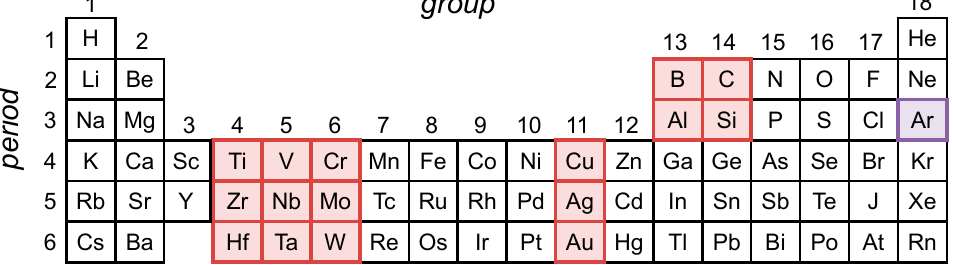
atoms, depending on the target material and the ion energy (i.e., the sputtering yield). Such numbers provided adequate statistics for the evaluation of the differential sputtering yields. The “detailed calculation with full damage cascades” type was chosen for the calculation. The default stopping powers that were provided by the program were used. We focused mainly on the evaluation of the sputtering yield for a normal ion impingement, however, several off-axis simulations were also